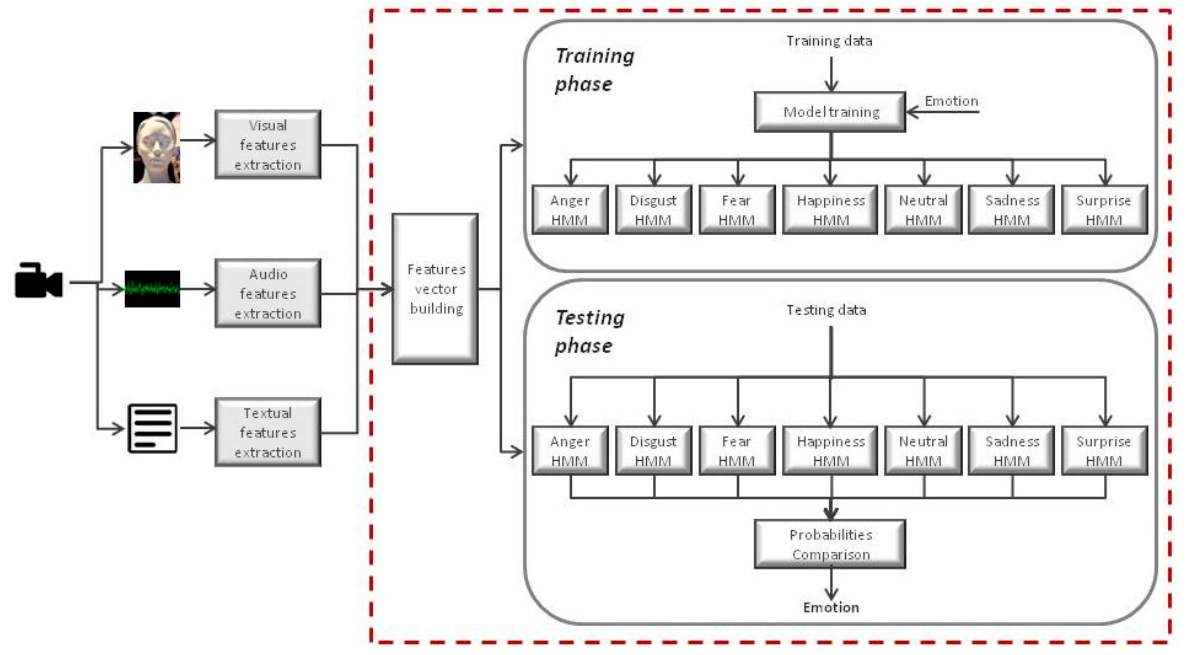
Figure 5. Overview of the proposed emotions classification model.